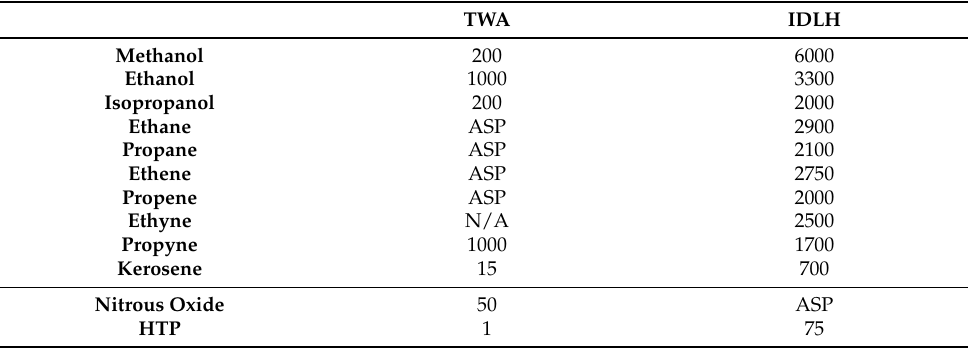
Table 13. Threshold limit values for the analyzed chemicals. Data from Ref.